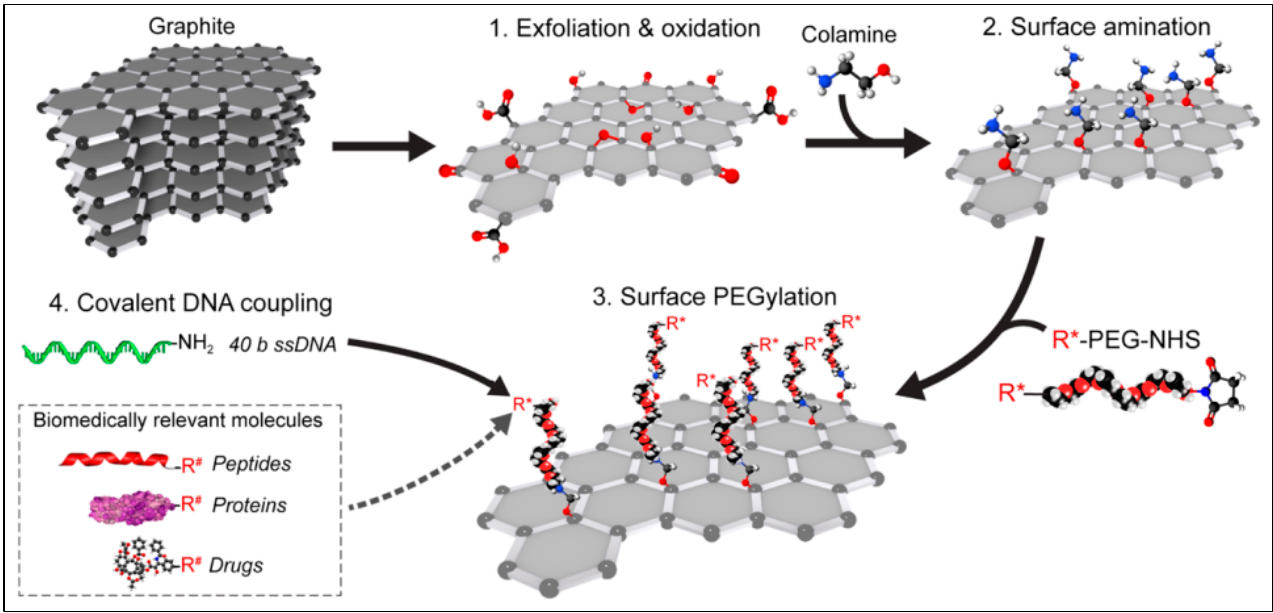
Figure 8. Schematic illustrating the synthesis of biocompatible GO. The image was reproduced with permission [121]